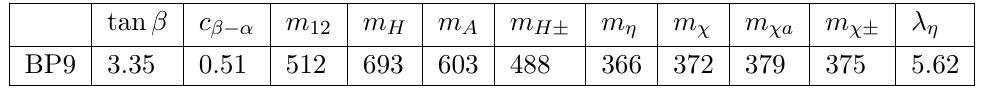
Table 4 . Benchmark point as drawn originally from the numerical scan which correspond to the curve of (cid:12)gure 14. All mass parameters are in